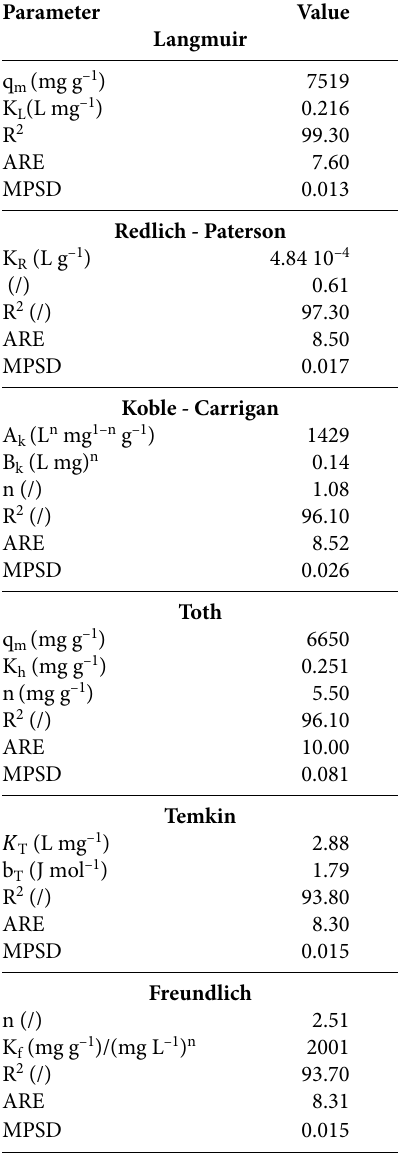
Table 5. Isotherm constants for the adsorp- tion of Ni(II)